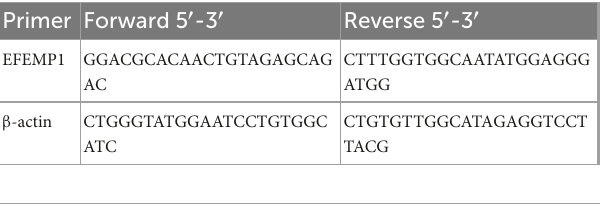
Enzyme-linked immunosorbent assay